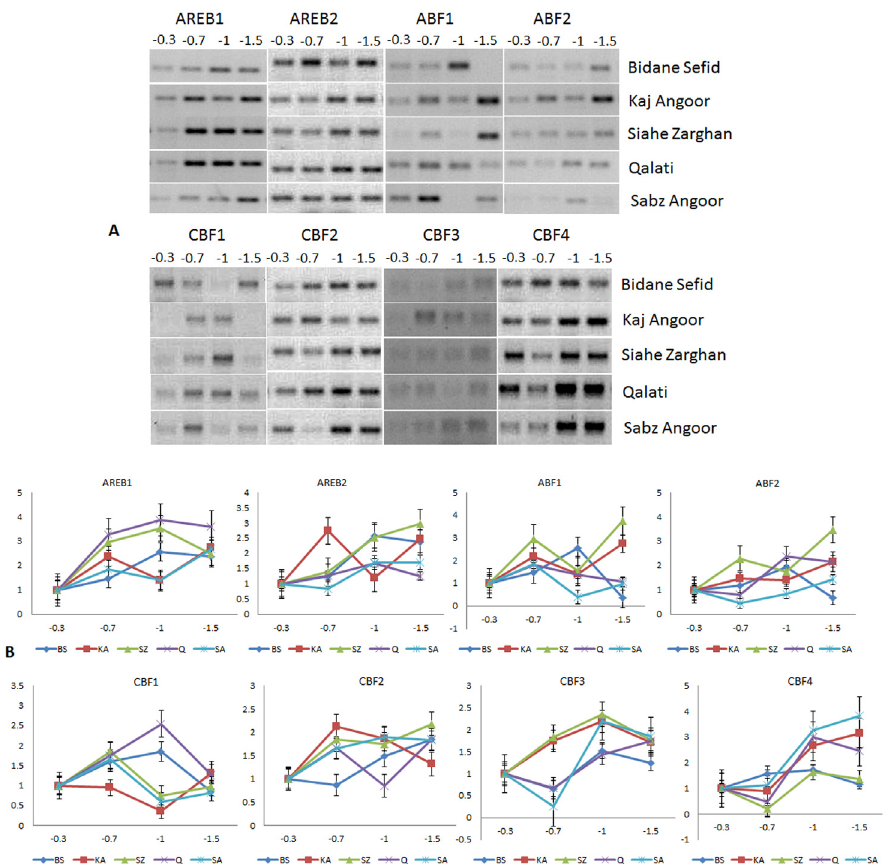
Fig 2. Semiquantitative (A) and Quantitative (B) expression analysis of AREB/ABF and DREB/CBF genes in the root tissues of five different varieties of grape under drought